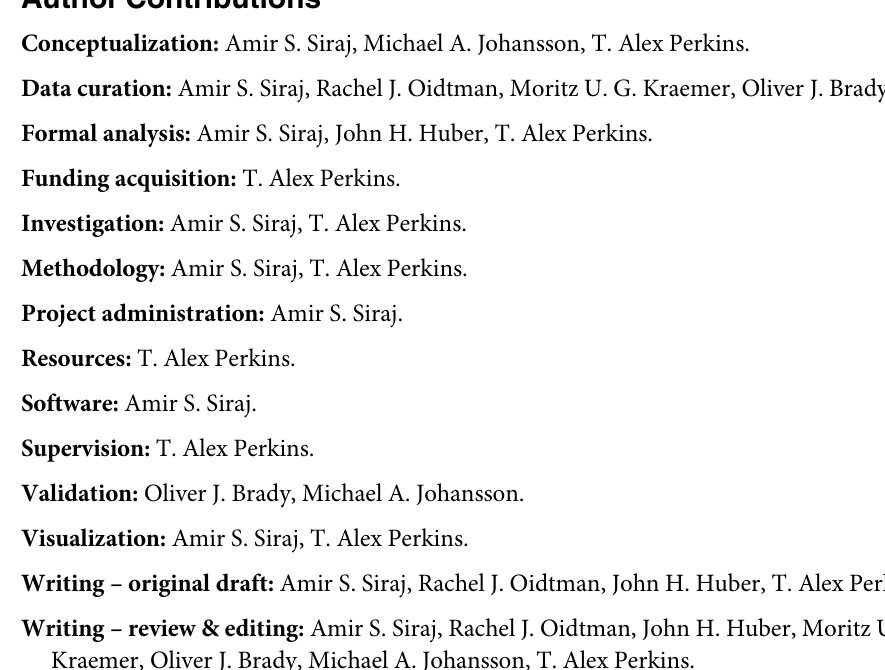
S3 Table. Total population globally that falls into different categories with respect to their relationship to the upper bound of the 95% CI of temperatures at which r peak (33.2˚C) by 2050 in each month. These projections are based on ensemble means of Global Circulation Models (GCMs) under three Representative Concentration Pathways (RCPs), climate change scenarios adopted by the International Panel for Climate Change (IPCC) [36]. S4 Table. Model parameters and their default values.